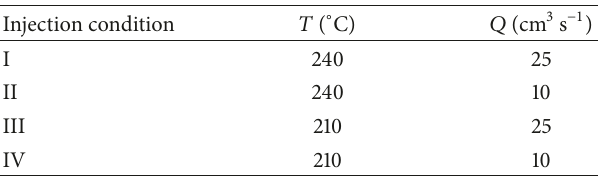
Table 1: Injection molding conditions for notched and unnotched PLGA